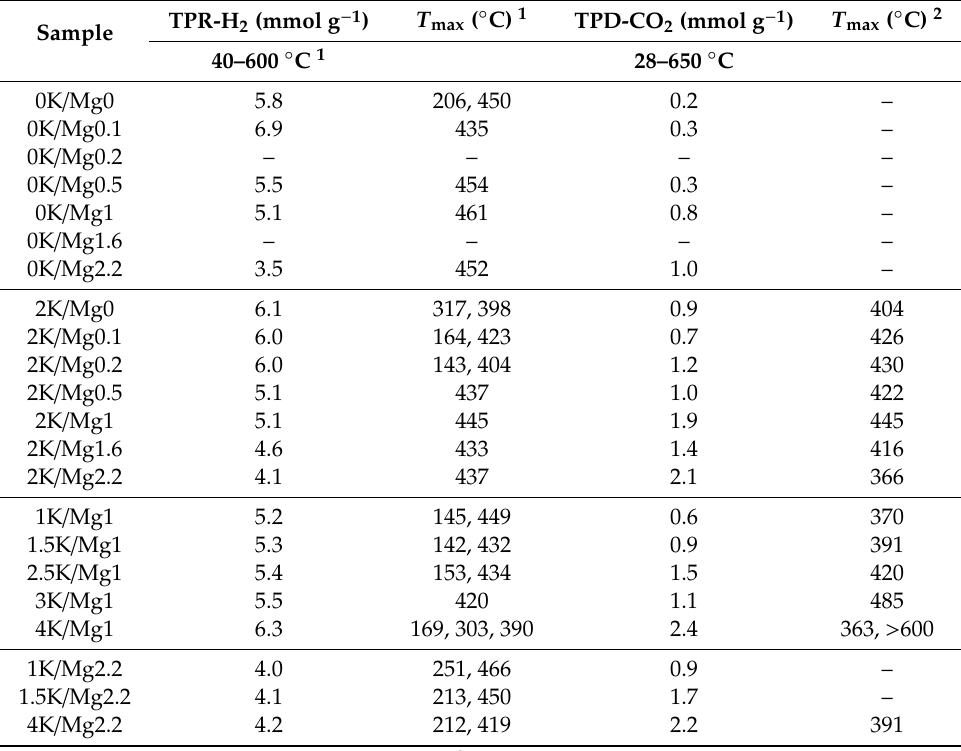
Table 2. Results of temperature-programmed reduction by hydrogen (TPR-H 2 ) and temperature-programmed desorption of CO 2 (TPD-CO 2 ) analysis of K / Co-Mg-Mn-Al mixed oxide